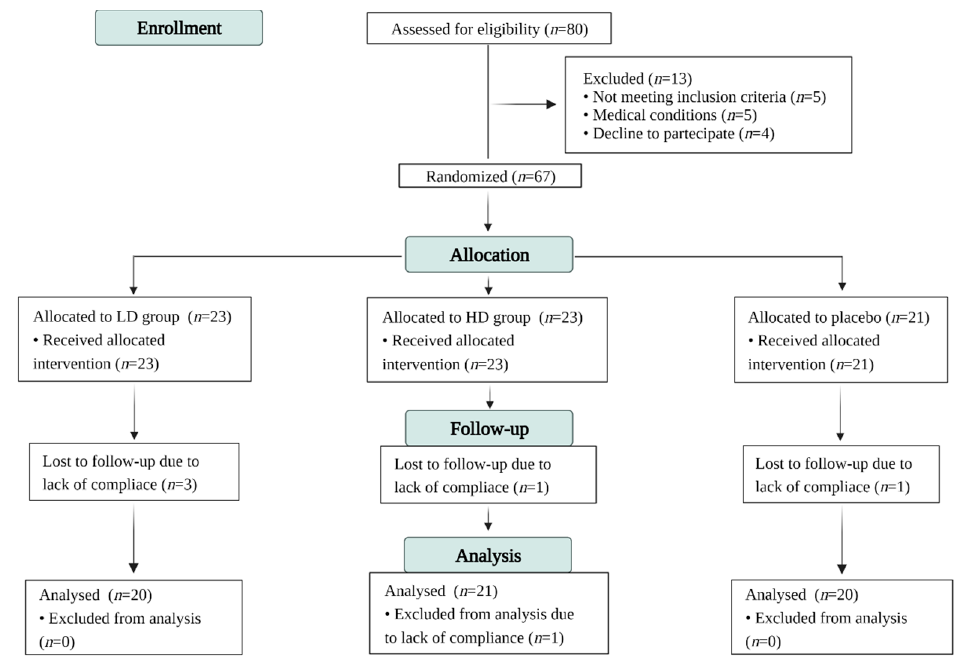
Figure 1. Consolidated Standards of Reporting Trials (CONSORT) flow diagram. HD, high-dose thinned nectarine group; LD, low-dose thinned nectarine group.